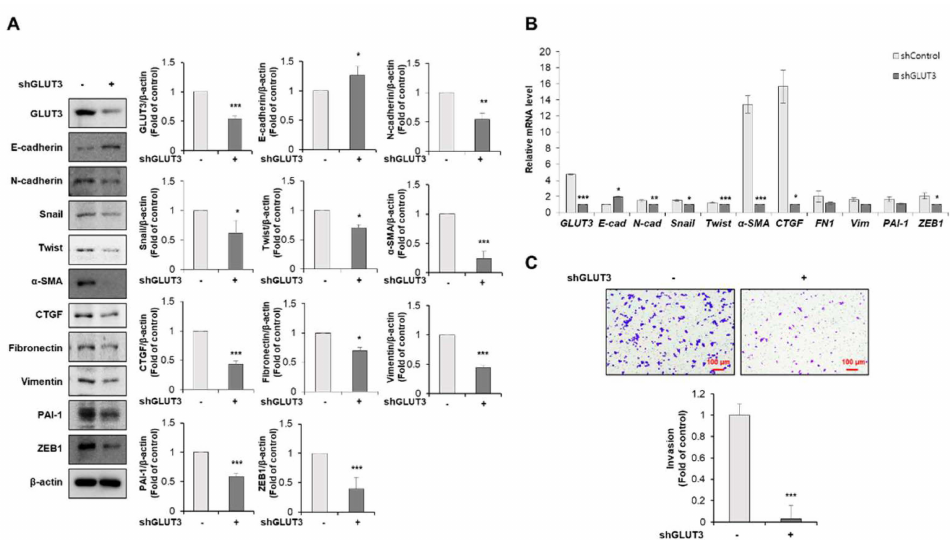
Figure 2. Knockdown of GLUT3 in SW620 cells reduces EMT process. ( A ) Western blot analysis was conducted for measuring the protein levels of GLUT3, E-cadherin, N-cadherin, snail, twist, α -SMA, CTGF, fibronectin 1 and vimentin, PAI-1 and ZEB1 in shGLUT3-induced SW620 cells. ( B ) qRT-PCR was conducted to measure the mRNA levels of GLUT3, E-cadherin (E-cad), N-cadherin (N-Cad), snail, twist, α -SMA, CTGF, fibronectin 1 (FN1) and vimentin (Vim), PAI-1 and ZEB1 in shGLUT3- transfected SW620 cells. ( C ) shGLUT3 was analyzed after 48 h using cell invasion assay to allow for the permeabilization of the transwell membrane. The membrane was stained with 0.2% crystal violet. Scale bar, 100 µ m. GLUT3, glucose transporter 3; EMT, epithelial–mesenchymal transition; α -SMA, α -smooth muscle actin; PAI-1, plasminogen activator inhibitor-1; ZEB1, zinc finger E-box binding homeobox 1, qRT-PCR, quantitative reverse transcription PCR; CTGF, connective tissue growth factor. Data are the mean ± standard deviation. Statistical significance was analyzed by analysis of